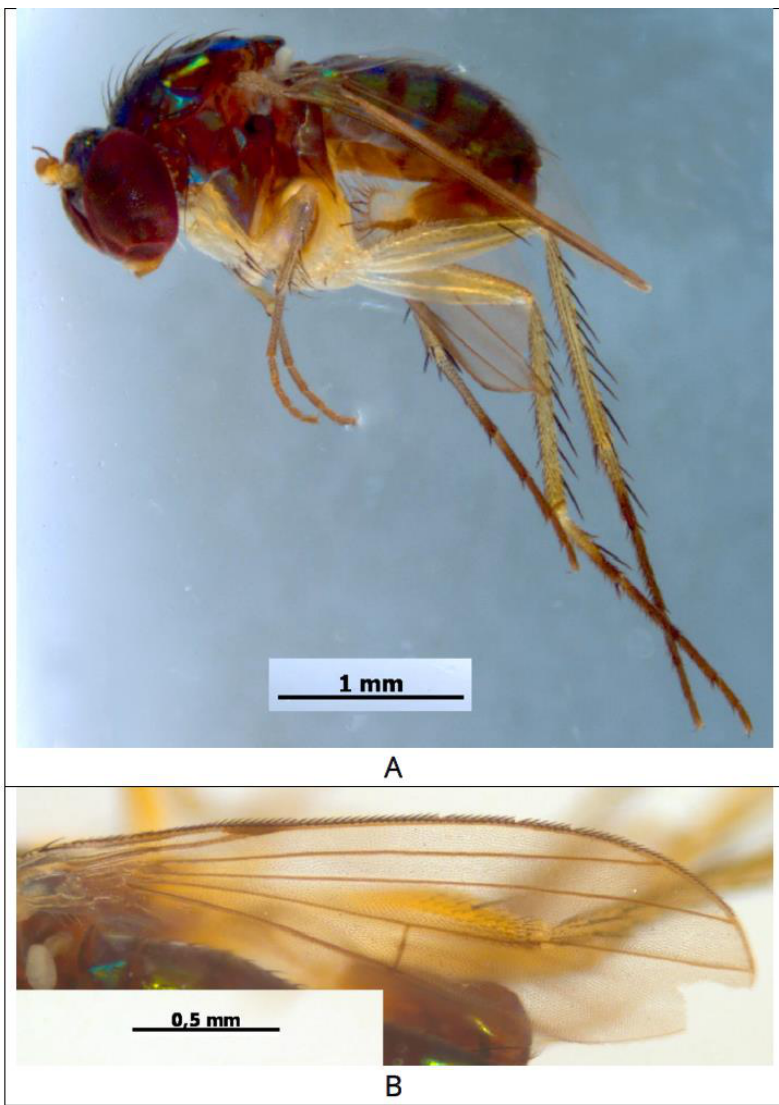
Fig. 1. Dolichopus lairdi Olejnicek, Mohsen & Ouda, 1995: A-male habitus;